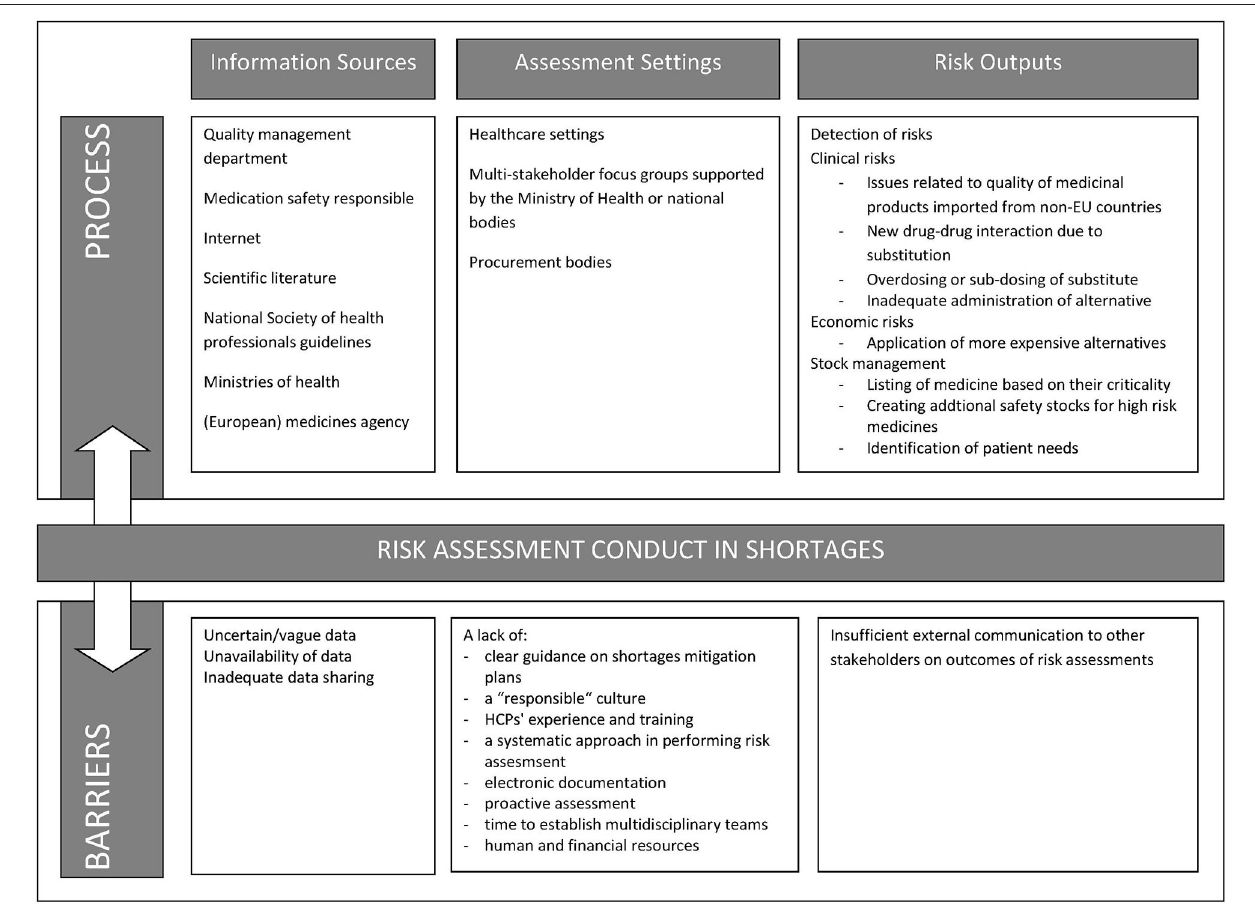
FIGURE 1 | Barriers along the process of risk